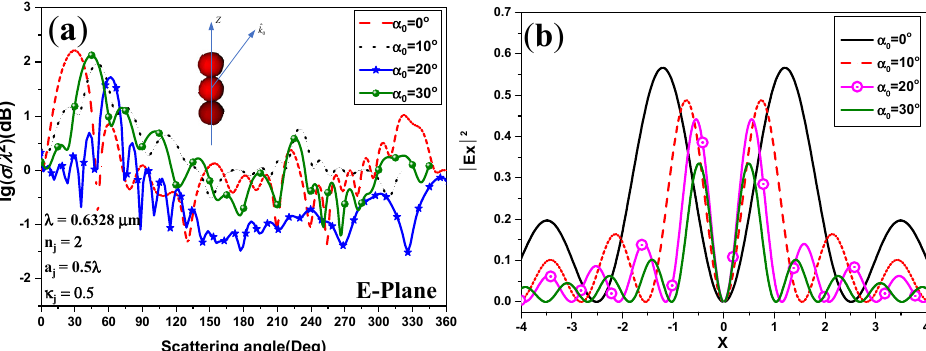
Figure 5. ( a ) Angular distributions of normalized RCS illuminated by an RCP HOBB based on the conical α 0 . ( b ) Distribution of a first-order Bessel beam with varying conical α 0 .